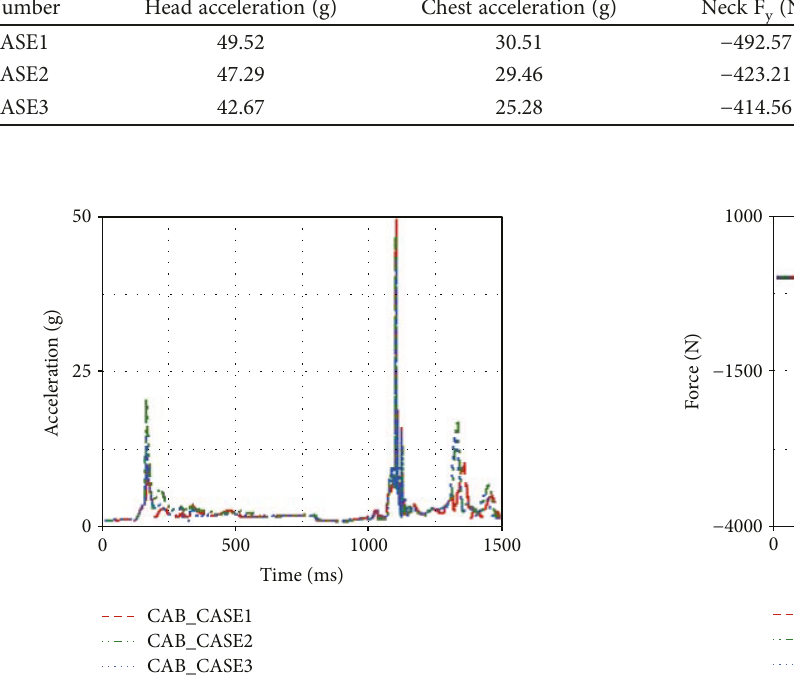
Figure 19: Head accelerations of di ff erent designs. Figure 20: Upper neck F